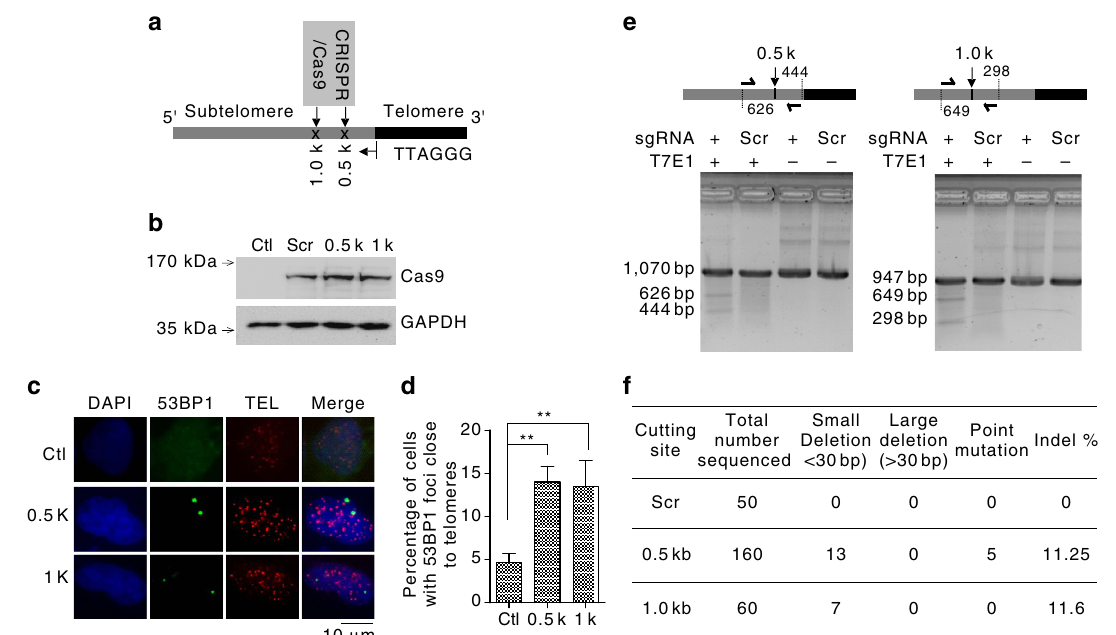
Figure 3 | Repair of CRISPR-Cas9-induced DSBs in the subtelomeric region. ( a ) Schematic diagram showing the strategy used to induce DSBs in the subtelomeric region (0.5 and 1kb from the first TTAGGG sequence in Xp/Yp). ( b ) Western blot analysis of Cas9 expression. Non-transfected cells served as a transfection control (Ctl) and plasmid with scrambled sgRNA (Scr) was used as a control for induction of DSBs. ( c ) Representative images of DSB repair foci in the subtelomere region. Scale bar, 10 m m. ( d ) Quantification of c . All values are the average ± s.d. of three independent experiments ( n ¼ 200). ** P o 0.01. The Student’s t -test was used to determine the statistical significance. ( e ) T7 endonuclease I (T7E1) susceptibility was used to screen and identify mutations and deletions introduced during DSBR. Cells exposed to scrambled sgRNA (Scr) were used as a control. The location of PCR primer hybridization, B 1kb apart, is shown. ( f ) A summary of the results from sequencing the PCR